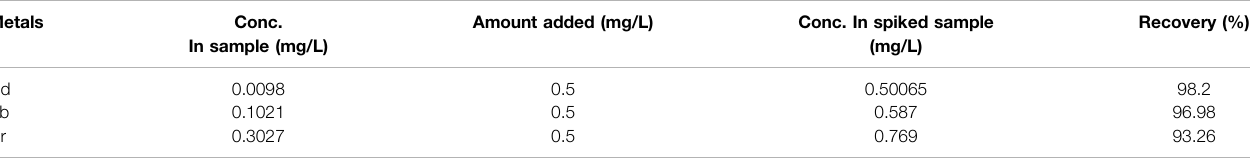
TABLE 3 | Recovery test values for the optimized procedure for heavy metal